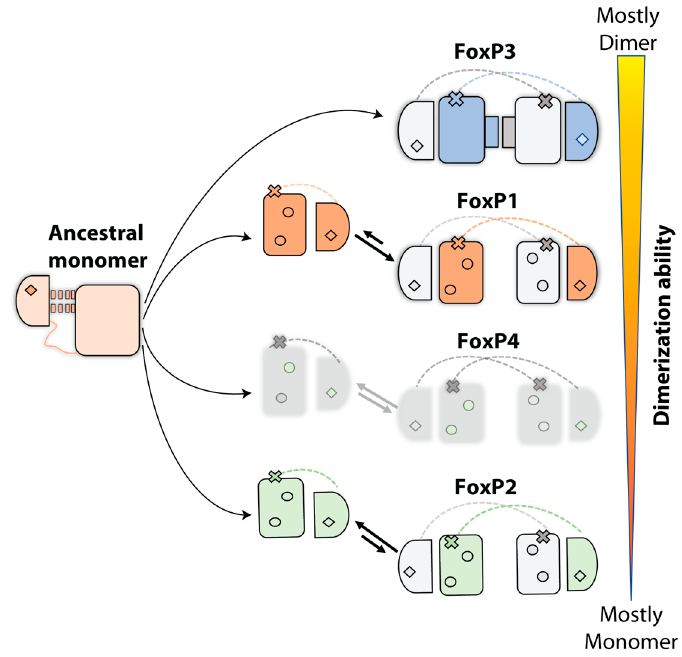
Figure 3. Proposed 3D-DS evolution pathway within the Fox family. An ancestral monomer accu- mulated non-deleterious random mutations (rhombus) before the emergence of 3D-DS in the Fox family. Inside this group, a hydrophobic network that stabilizes the dimerization interface could be considered as residues that favor dimerization, but they are insufficient to enable dimerization by themselves. The conserved Ala39Pro mutation (x) in the hinge region allowed this ancestral monomer to generate 3D-DS dimers within the FoxP subfamily. All residue substitutions from the monomeric ancestor (rhombus) are conserved in the FoxP subfamily, although FoxP3 contains some sequence differences that allow an additional stabilization of the interface formed by helices H 1 and H 2 (small rectangles). FoxP4, a still uncharacterized member of this subfamily, is shown in gray, but its sequence similarity with respect to FoxP1 and FoxP2 suggests that it could have a dimerization propensity within the protein concentration range defined by the dimer dissociation constants of these proteins.